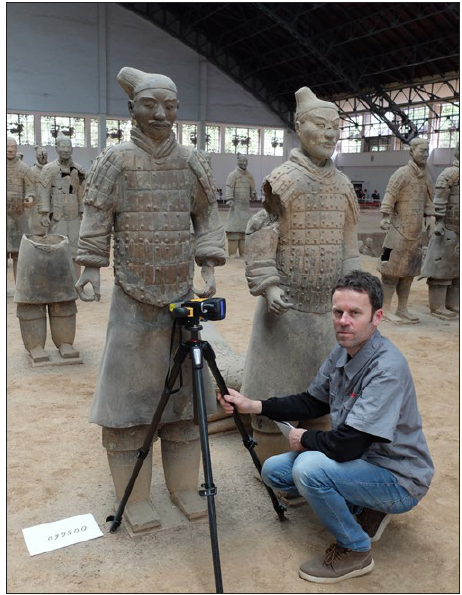
Figure 2: Principal Research Fellow Patrick Quinn in China working on one of the terra- cotta warriors (Photo: Patrick